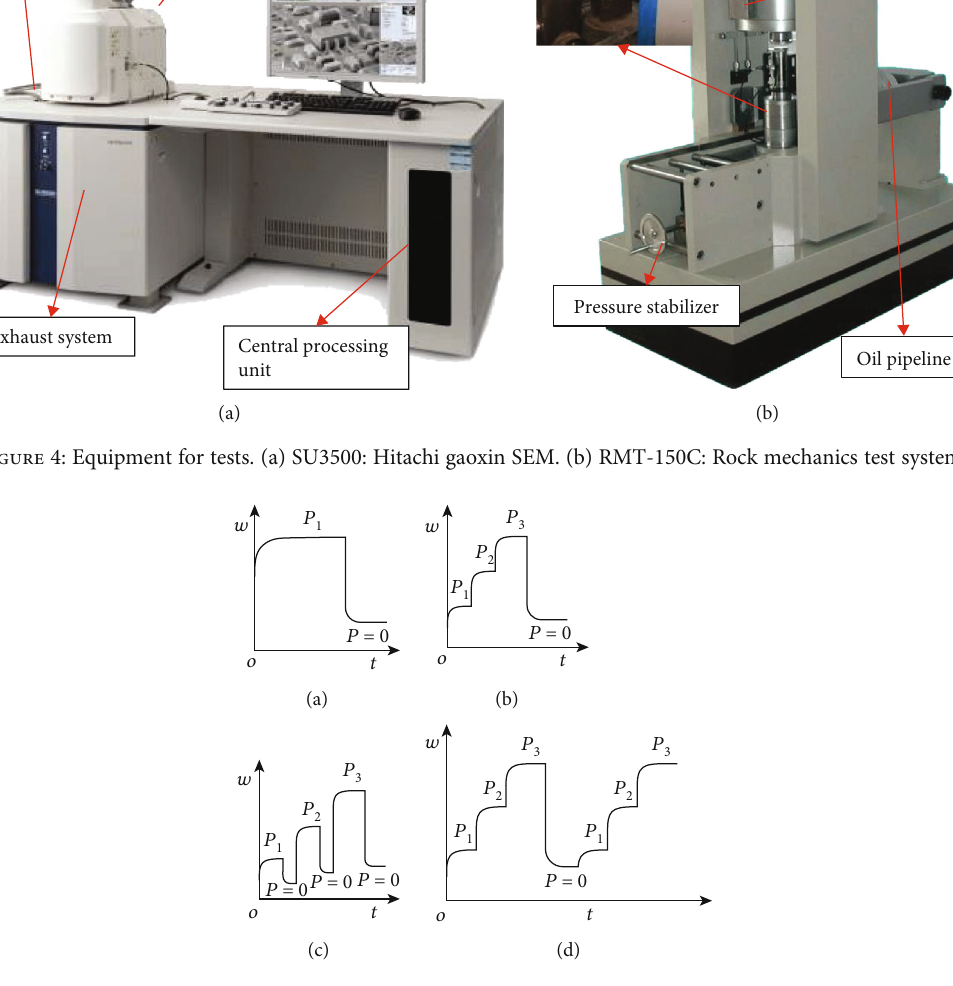
Figure 5: Loading methods for creep tests. (a) One-stage loading. (b) Multistage monotonic loading. (c) Multistage cyclic loading. (d) Speci fi c loading methods of stress at various